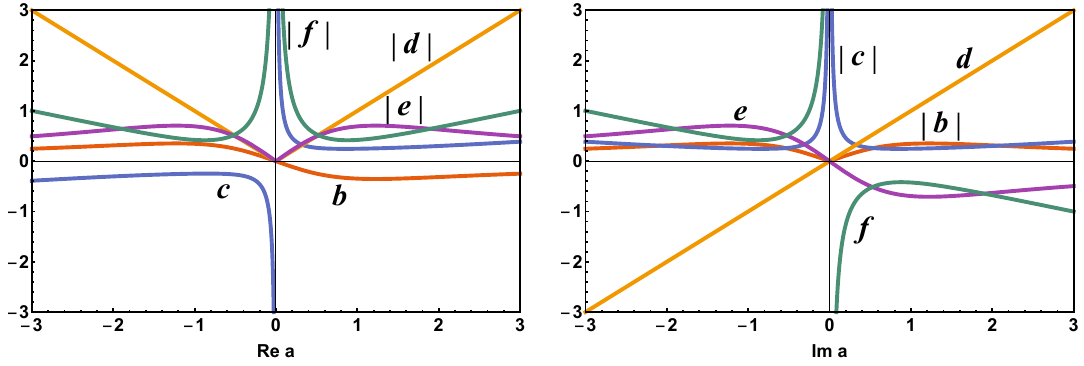
Figure 4 . The superpotential couplings, b; c; d; e , and f as functions of a that correspond to the Starobinsky solutions in